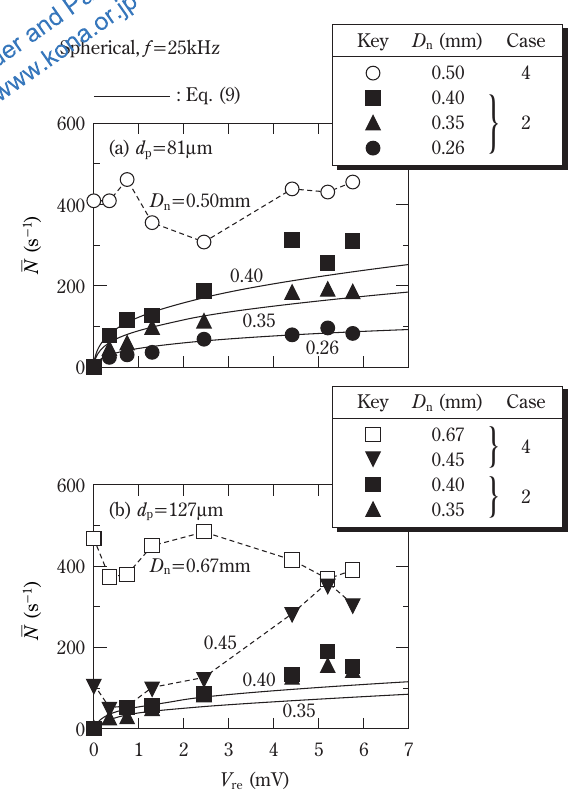
Fig. 9 Average discharge rate of irregular particles, N (cid:3) , under vari- ous operating